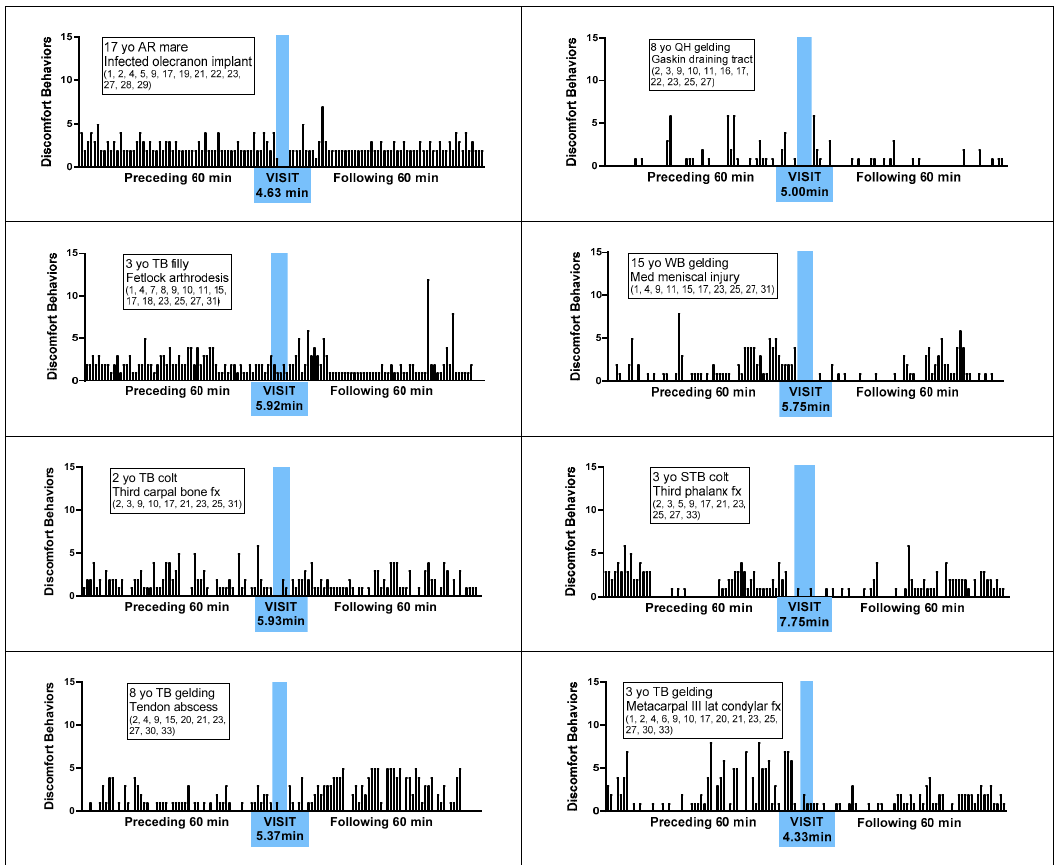
Figure 1. Discomfort behaviors per minute displayed by 20 horses with various orthopedic surgical conditions, during the 60 min preceding a caretaker visit, during a caretaker visit, and 60 min following a caretaker visit. Time of caretaker visit is highlighted in blue. Numbers in parentheses refer to the particular set of discomfort behaviors observed for the horse, as described in Appendix A Table A1.